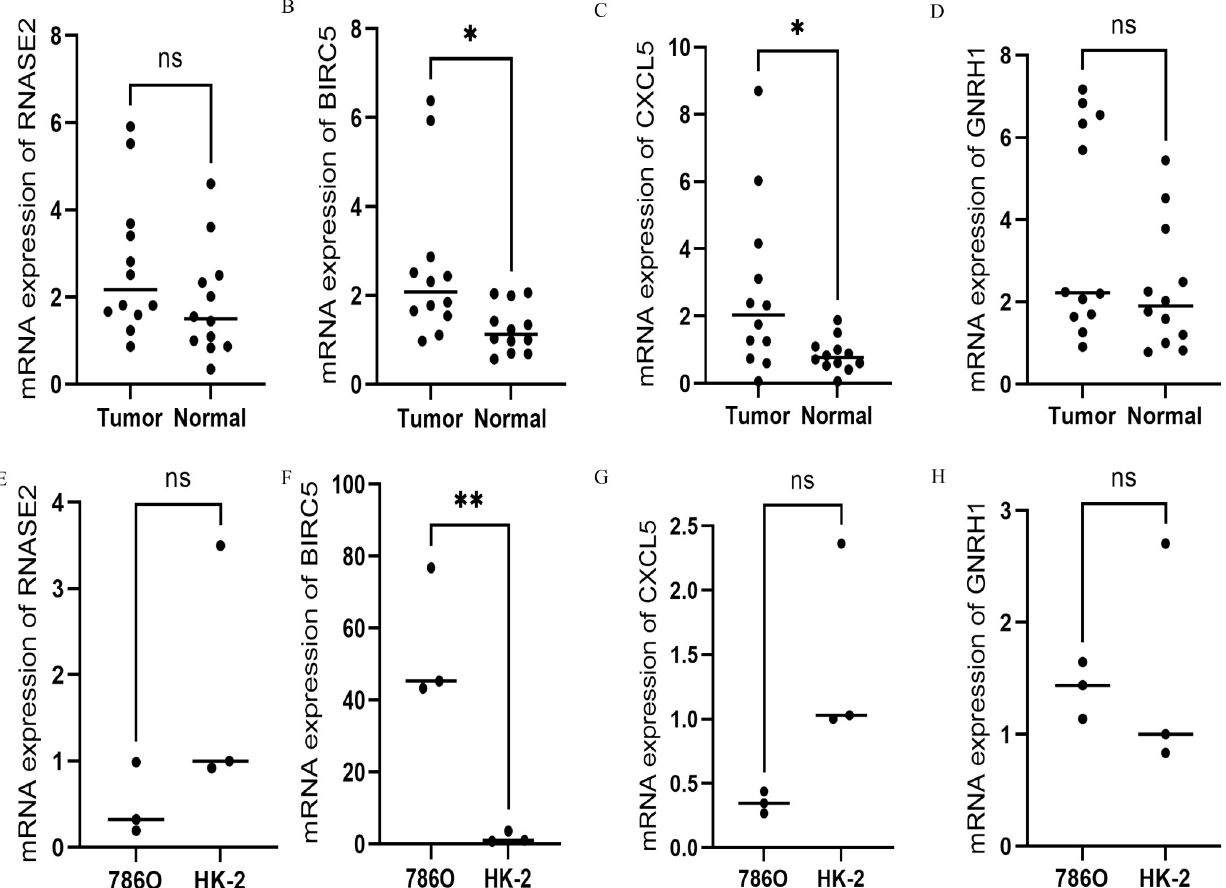
Fig 8. The mRNA levels of the four hub genes. (A–D) Expression of the four genes in 12 pairs of ccRCC and para-cancer tissues by qRT-PCR. (E–H) expression of the four hub genes in cancer cells and normal kidney cells by qRT-PCR ( �� P < 0.01; � P < 0.05).